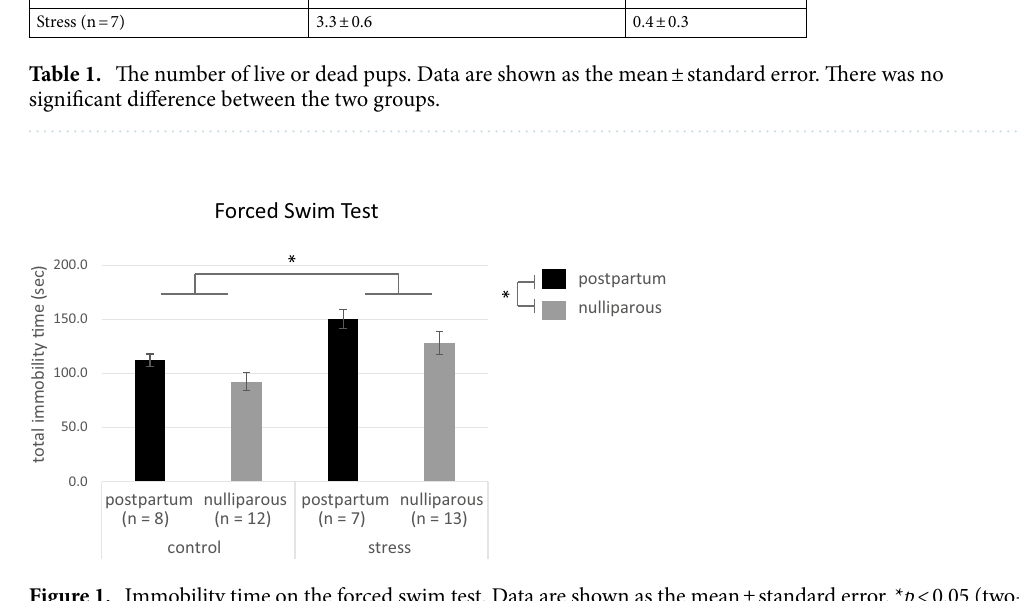
Figure 1. Immobility time on the forced swim test. Data are shown as the mean ± standard error. * p < 0.05 (two- way analysis of variance) for control versus stress and postpartum versus